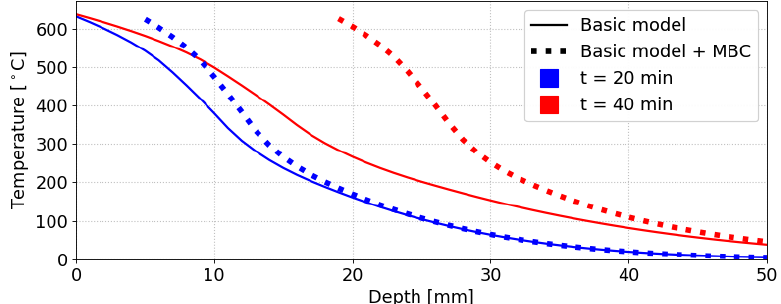
Figure 7. Example of the effect of a moving boundary condition (MBC). Semi-infinite domain.